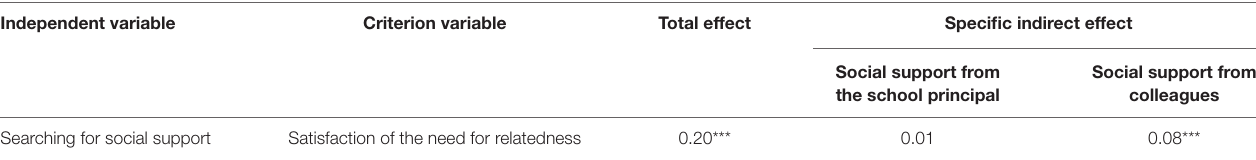
TABLE 3 | Bootstrapped standardized regression coefficients of indirect and total effects of searching for social support on teachers’ satisfaction of the need for relatedness via received social support from the school principal and colleagues. Independent variable Criterion